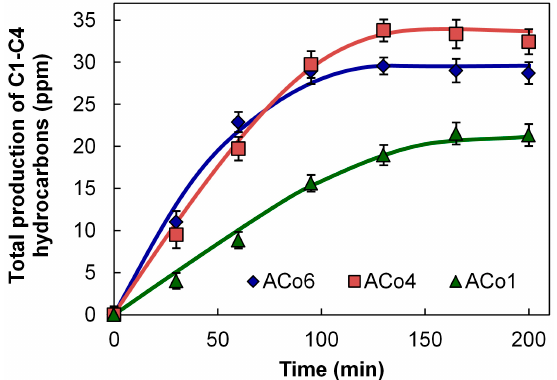
Figure 6. Molar production in the reaction versus time using aerogel based electro ‐ catalysts.